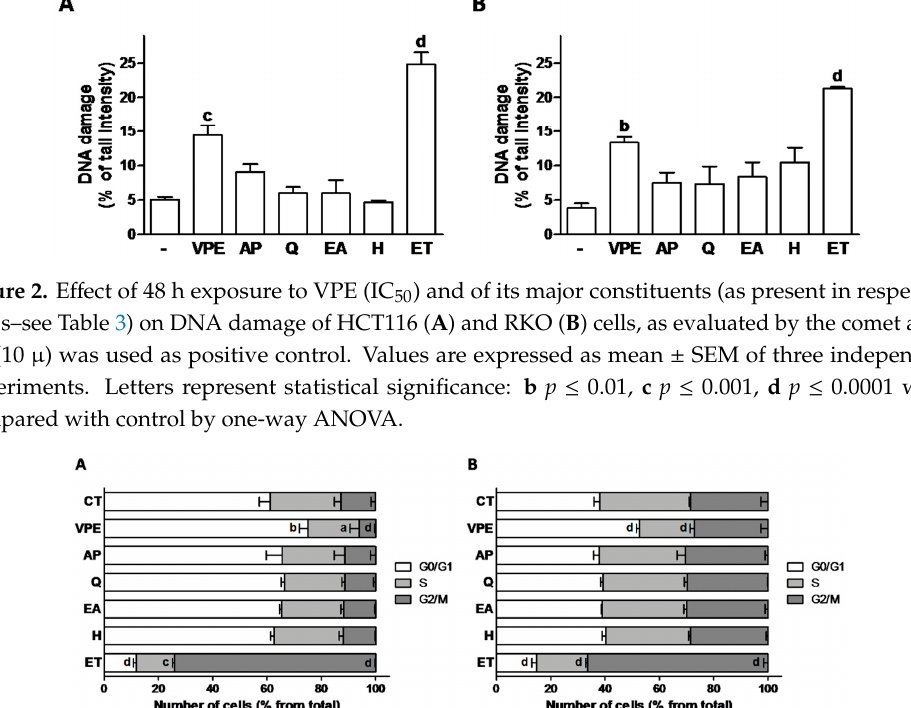
Figure 3. Effect of 48 h exposure to VPE (IC 50 ) and of its major constituents (as present in respective IC 50 – see Table 3) on cell cycle of HCT116 ( A ) and RKO ( B ) cells, as assessed by flow cytometry. Values are